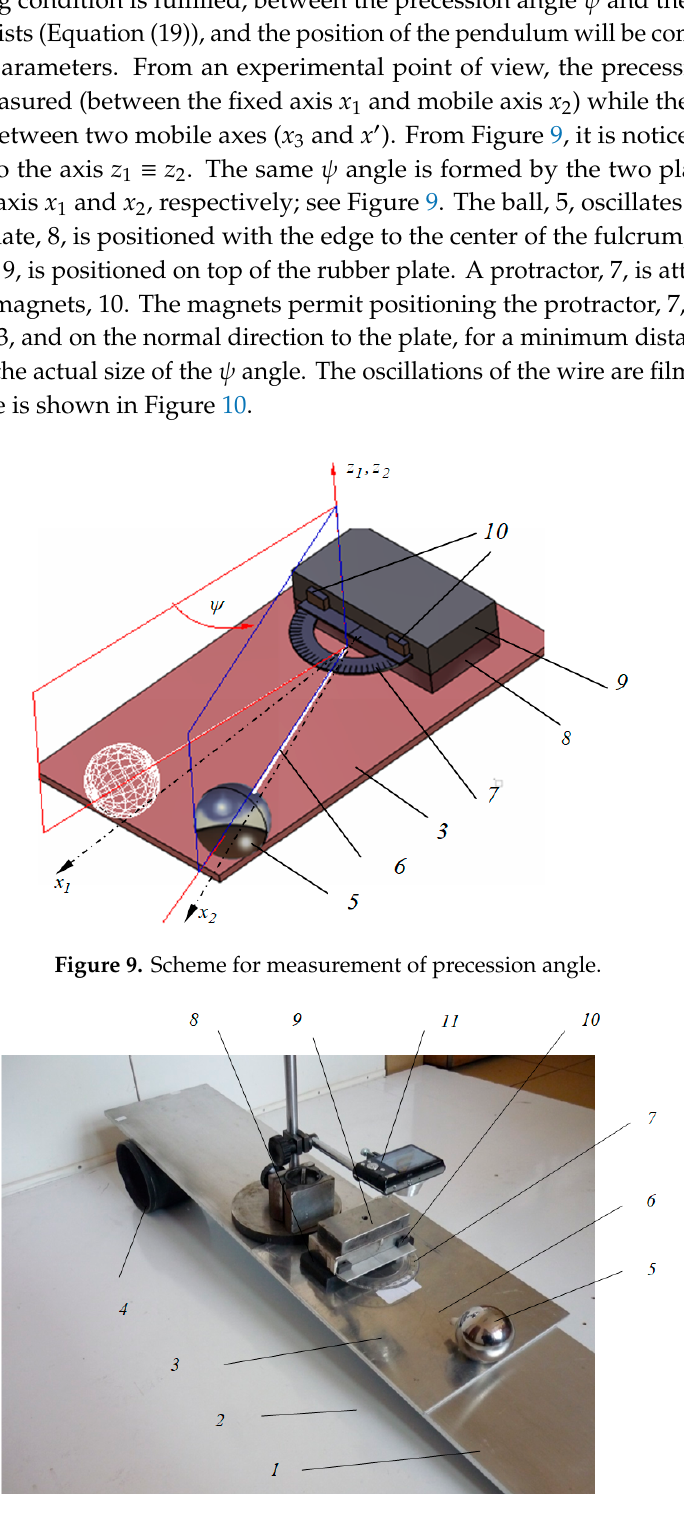
Figure 10. Experimental device.